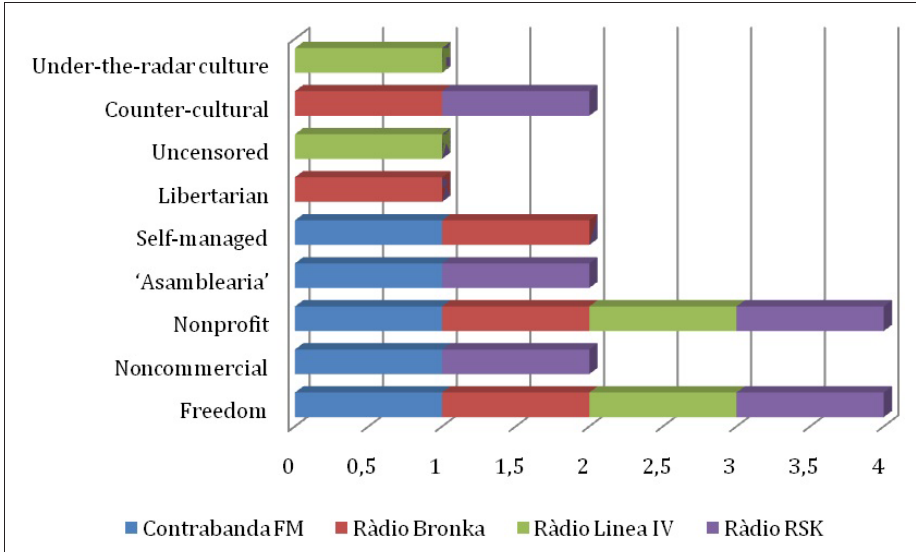
Figure 2: Contrabanda FM, Ràdio Bronka, Ràdio Linea IV and Ràdio RSK definition (2016). Source: Compiled by author based on the stations’